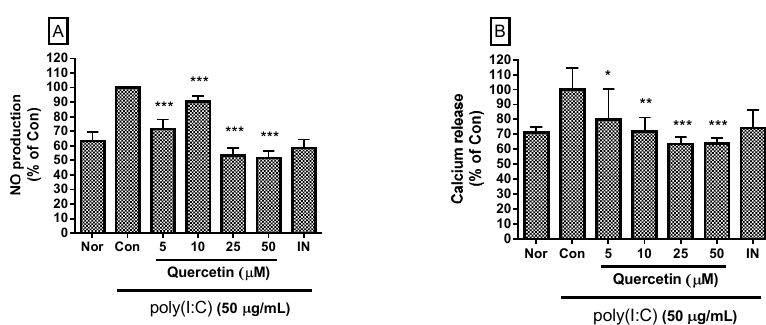
Figure 2. Effect of quercetin on nitric oxide (NO) production ( A ) and calcium release ( B ) by dsRNA ‐ induced RAW 264.7 mouse macrophages. After 24 h treatment, NO production was measured by the Griess reaction assay. Calcium release was measured with the Fluo ‐ 4 calcium assay after an 18 h treatment. The normal group (Nor) was treated with media only. The control group (Con) was treated with 50 μ g/mL of the dsRNA synthetic analog polyinosinic ‐ polycytidylic acid (poly(I:C)) alone. IN, indomethacin (0.5 μ M). Values are mean ± standard deviation of three independent experiments. * p < 0.05 vs. Con; ** p < 0.01; *** p < 0.001. Significant differences were examined using one ‐ way analysis of variance test followed by Tukey’s multiple comparison test.